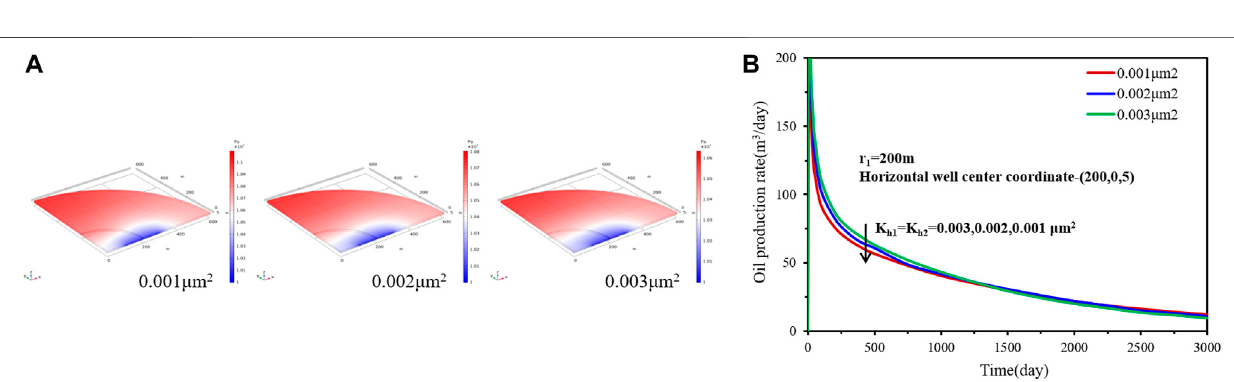
FIGURE 11 | Effect of inner region permeability on (A) transient pressure and (B) rate decline performance.